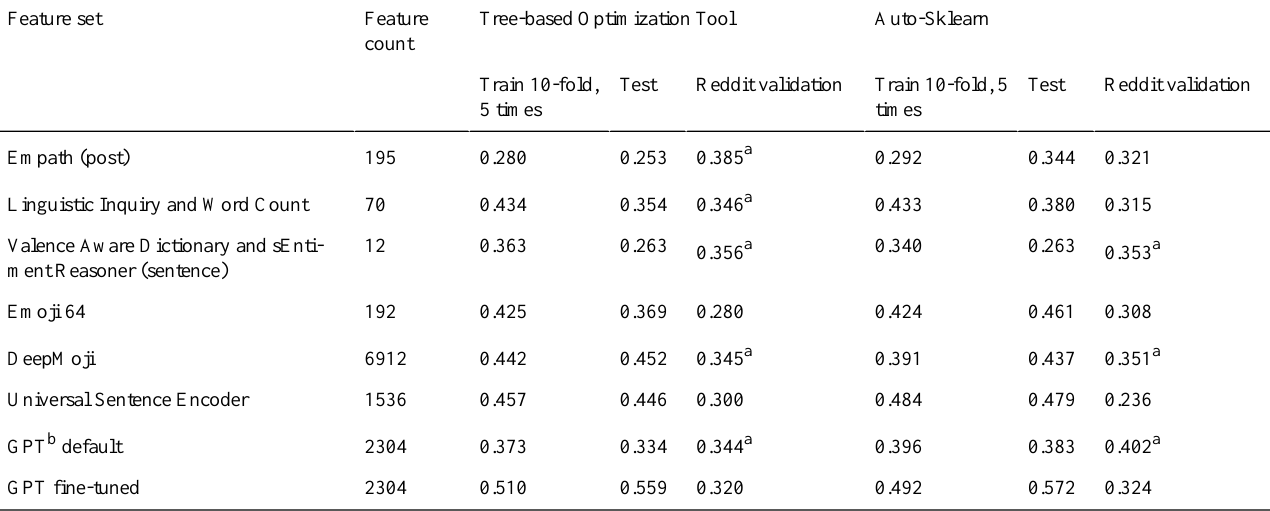
Table 1. Benchmarking by features, automated machine learning methods, and datasets with the macro-F1 metric.